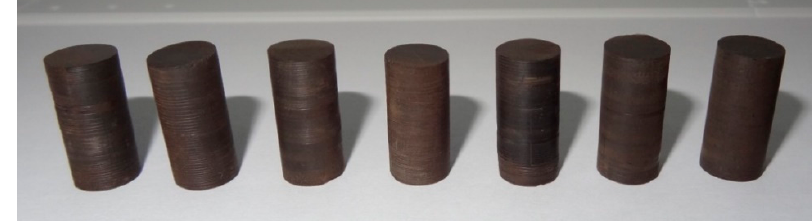
Figure 1. Oil shale samples in the pyrolysis experiments (size: Φ = 10 × 20 mm).